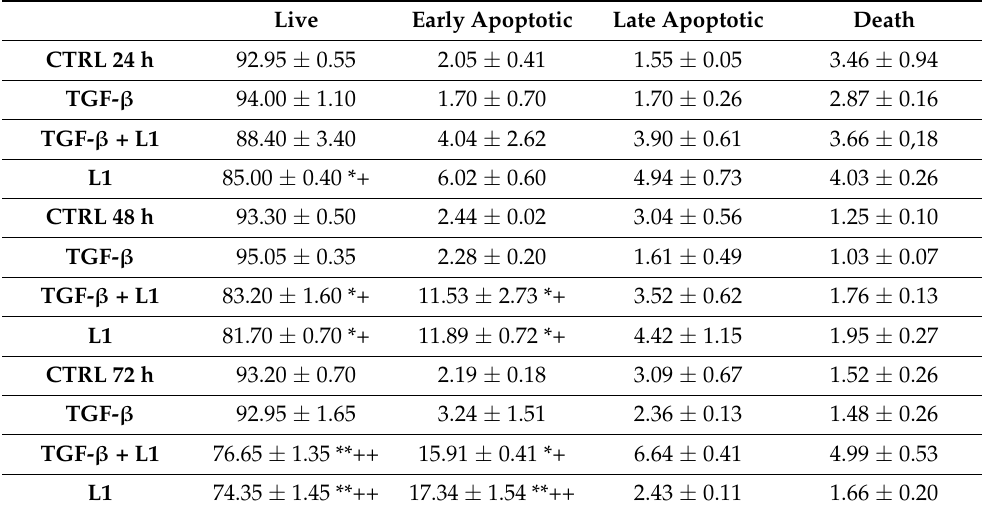
Table 2. Flow Cytometric Analysis of Annexin V/PI Staining Performed on HeLa Cells after 24, 48 and 72 h of L1 and TGF- β Treatment.